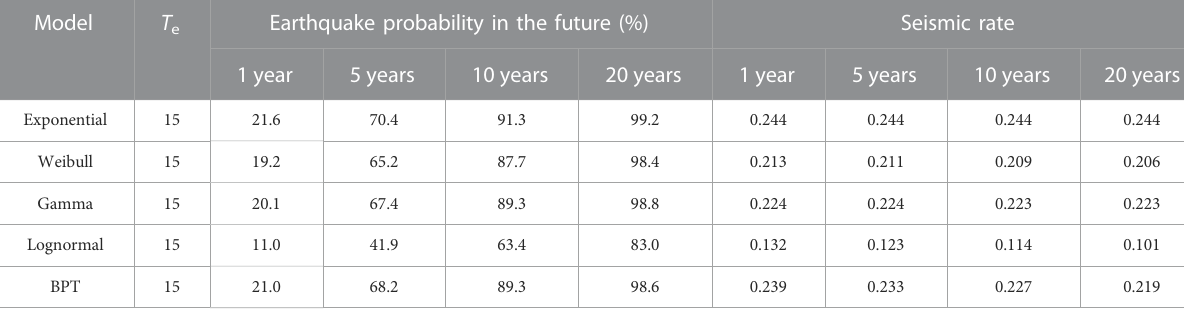
TABLE 5 Occurrence probability and seismic rate of M ≥ 7.0 earthquakes in Taiwan in the future.